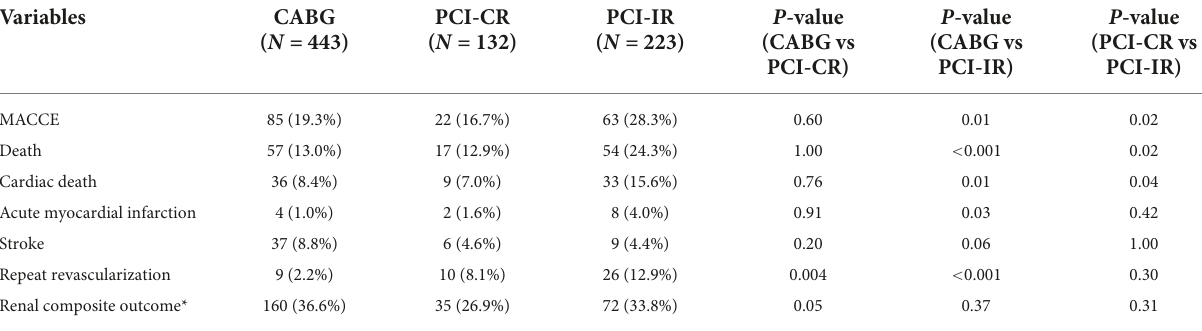
TABLE 3 Cumulative incidence of events at 5 years in the CABG, PCI-CR, and PCI-IR groups.